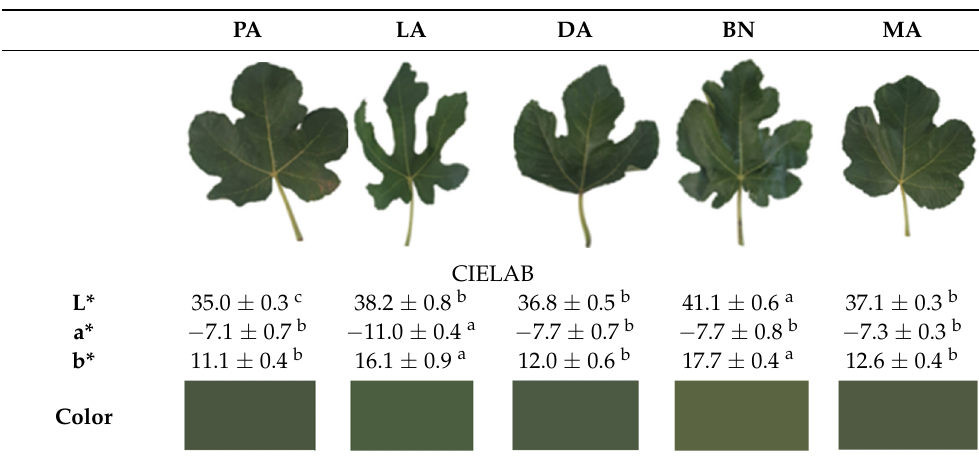
Table 1. Color analysis in fig leaves.